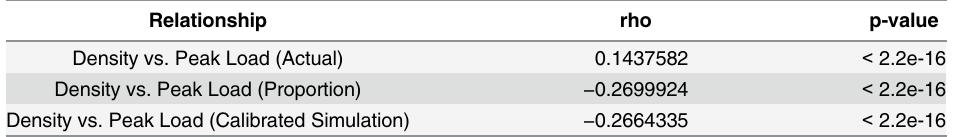
Table 2. Spearman correlation coefficients during AUTUMN